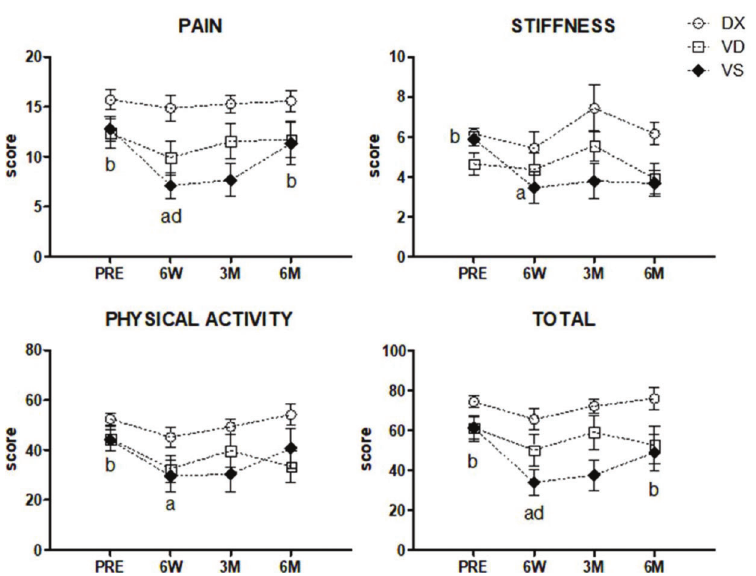
Figure 2 - WOMAC score evaluation. Significant effects were observed over time in the WOMAC total score and pain, stiffness and physical activity subscores (all, p o 0.05). Additionally, significant effects between groups were observed in the pain ( p =0.03), stiffness ( p =0.03), and physical activity ( p =0.03) subscores, but not in the WOMAC total score ( p =0.07). Pairwise verification demonstrated differences between DX and VS. Further separate analysis revealed significant differences only within the VS group in terms of the pain ( p =0.01), stiffness ( p =0.04), and physical activity ( p =0.05) subscores and the WOMAC total score ( p =0.03). Symbols represent mean values, dashed and straight lines represent standard deviations. 6 W: six weeks, 3 M: three months and 6 M: six months; a: compared to PRE; b: compared to 6 W; c: compared to 3 M; d: compared to 6 M. Table 2 - WOMAC questionnaire data. Data from the WOMAC questionnaire were divided into the score for three domains (pain, stiffness and function) and the total score for all three groups. Group PRE 6 W 3